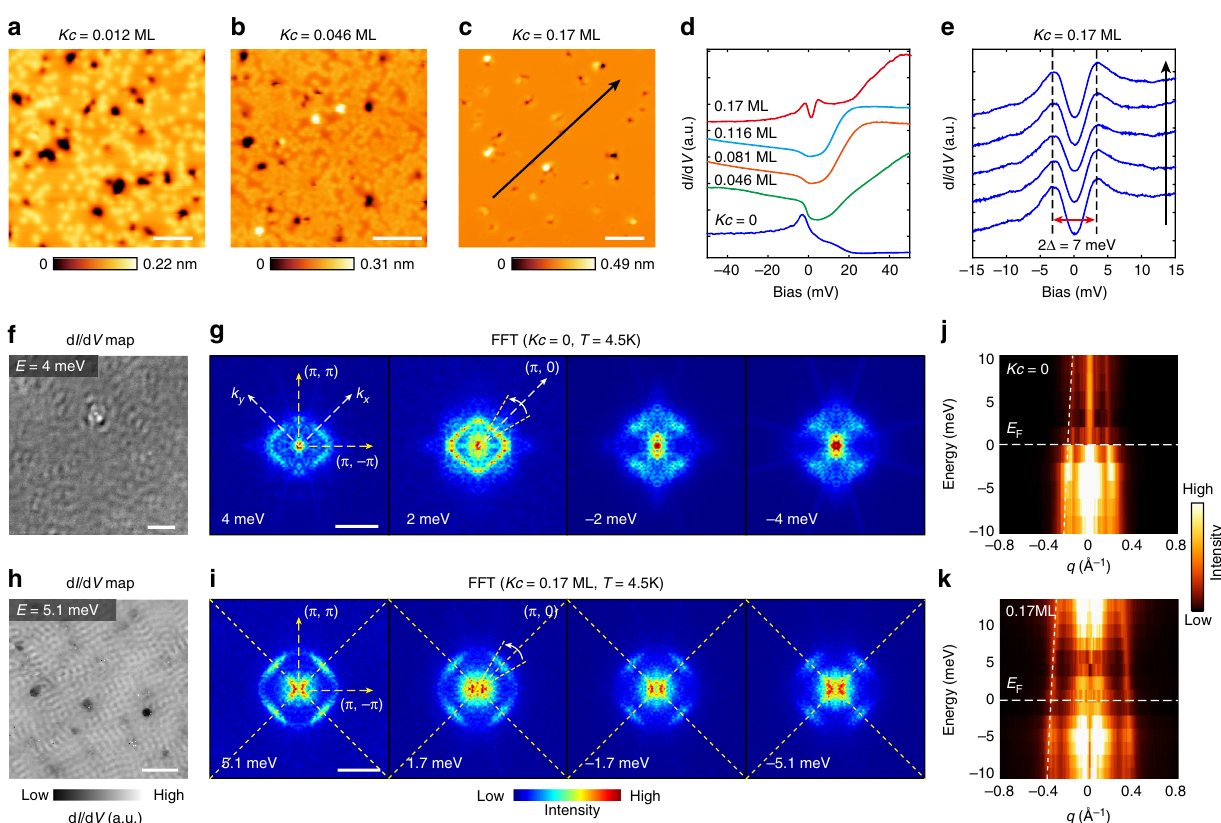
Fig. 6 Effect of surface potassium (K) dosing on RbFe 2 As 2 . a – c Topographic images of RbFe 2 As 2 with various K coverage ( Kc = 0.012 ML, 0.046 ML, 0.17 ML, respectively). K atoms appear as random bright spots at low Kc . (Setpoints of a: V b = 1 V, I = 50 pA; b: V b = 1 V, I = 20 pA, c: V b = 0.2 V, I = 200 pA; scale bars: 10 nm). d Spatially averaged d I /d V spectra of RbFe 2 As 2 with various Kc ( V b = 50 mV, I = 200 pA, Δ V = 1 mV, T = 4.5 K for all the spectra). e Low-energy d I /d V spectra of RbFe 2 As 2 at Kc = 0.17 ML ( V b = 15 mV, I = 300 pA, Δ V = 1 mV, T = 4.5 K), taken along the arrow in panel c . A spatially uniform gap with the size of 2 Δ = 7.0 meV is observed. f A representative d I /d V map taken at Kc = 0, T = 4.5 K ( V b = 10 mV, I = 200 pA, Δ V = 1 mV; scale bar: 10 nm). g Selected FFT images of d I /d V maps with Kc = 0 (scale bar: 0.3 Å -1 ). The FFTs are mirror symmetrized along ( π , π ) and ( π , − π ) directions. h A representative d I /d V map taken at Kc = 0.17 ML ( V b = 10 mV, I = 200 pA, Δ V = 1 mV, T = 4.5 K; scale bar: 10 nm). i Selected FFT images of the d I /d V maps with Kc = 0.17 ML (scale bar: 0.3 Å -1 ); FFTs are also mirror symmetrized along ( π , π ) and ( π , − π ) directions. j FFT pro fi les along the ( π , 0) direction for Kc = 0 (averaged over a 30° angle, as indicated in the E = 2 meV image in panel g ). Parabolic fi t (dashed curve) gives E b = 25 meV and q F = 0.19 Å − 1 . k FFT pro fi les along the ( π , 0) direction (averaged over a 30° angle) for Kc = 0.17 ML. Parabolic fi t (dashed curve) gives E b = 50 meV and q F = 0.34 Å −